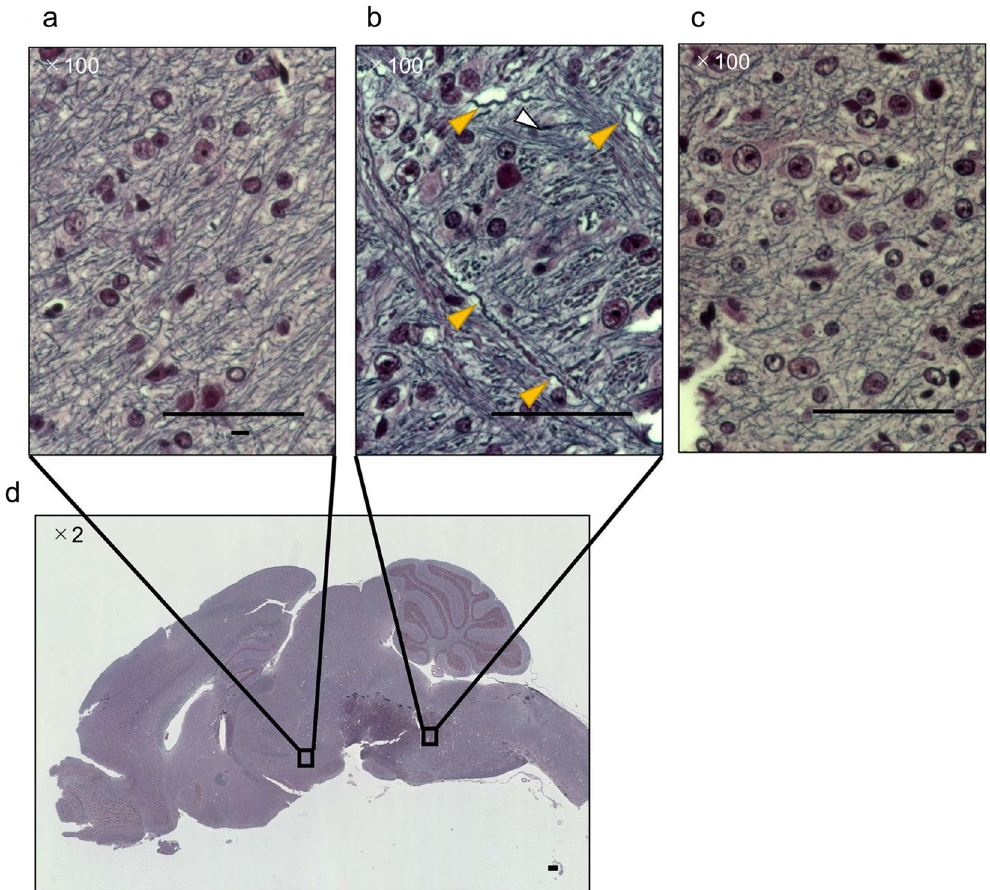
Figure 4. Bodian-stained brain after application of the LISW in the Upper neck group and intact group. ( a , b , d ) Bodian-stained brain specimen after application of the LISW to the Upper neck group. ( a ) There were no obvious axonal changes in the hypothalamic region. ( b ) Multiple axonal undulations were observed in the medulla oblongata region (yellow arrows). Axonal swellings were observed in several locations (white arrows). ( c ) Bodian-stained brain specimen of an uninjured mouse with no obvious axonal changes in the medulla oblongata region. ( a – c ) scale 50 μm. ( d ) scale 200